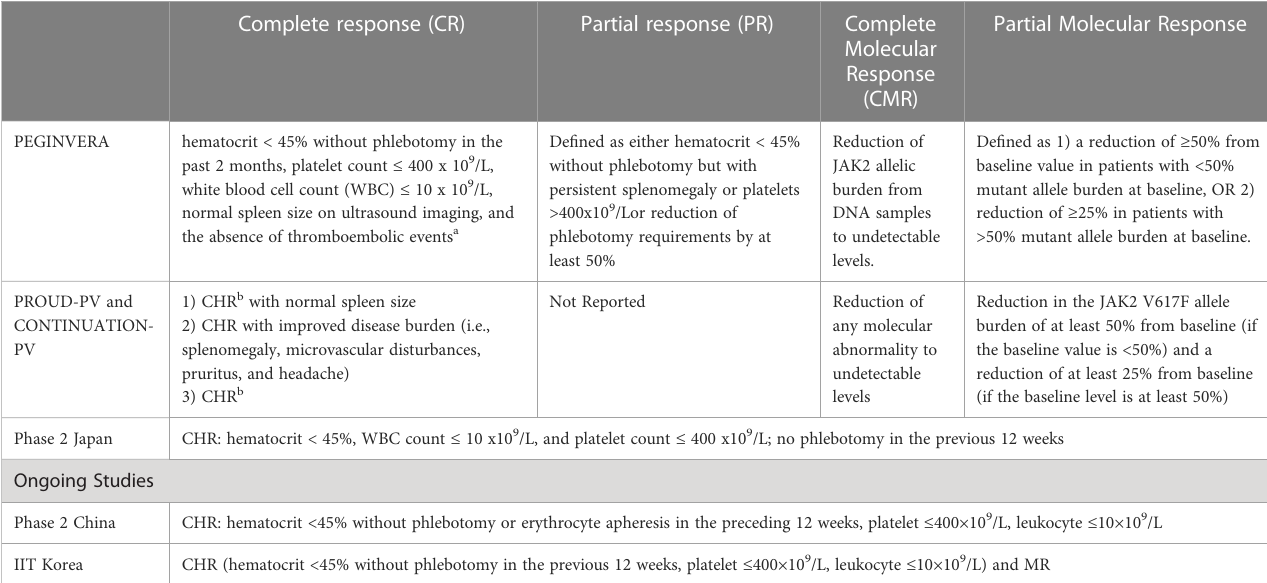
TABLE 1 Measured response de fi nitions for the clinical studies of ropeginterferon alfa-2b for the PV treatment. Complete response